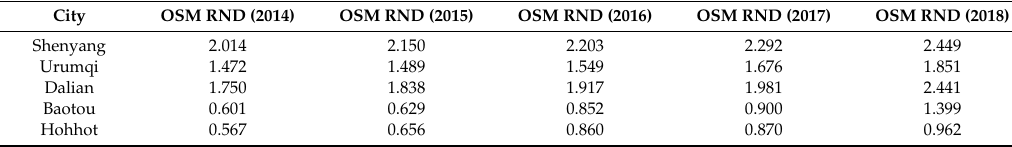
Table 2. The OSM road network density of the five